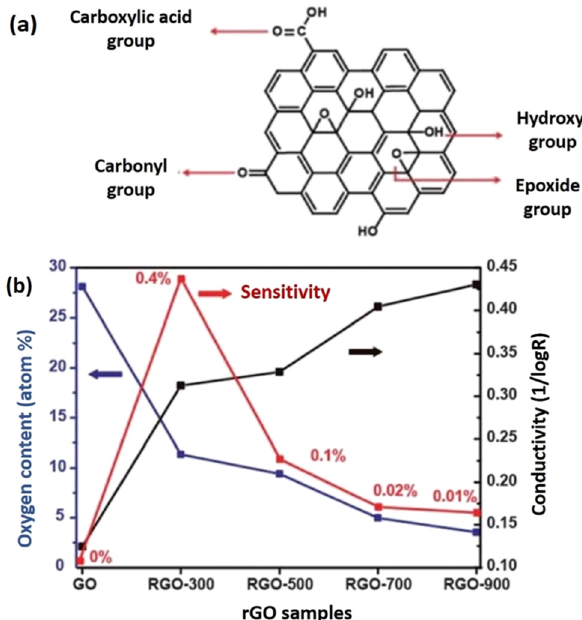
Figure 20: ( a ) rGO structure with the attached carbonyl, carboxylic, hydroxyl, and epoxide groups considered as defective sites and ( b ) oxygen content, conductivity, and sensitivity of rGO samples with di ff erent treatment temperature. Adapted from ref. [ 128 ]